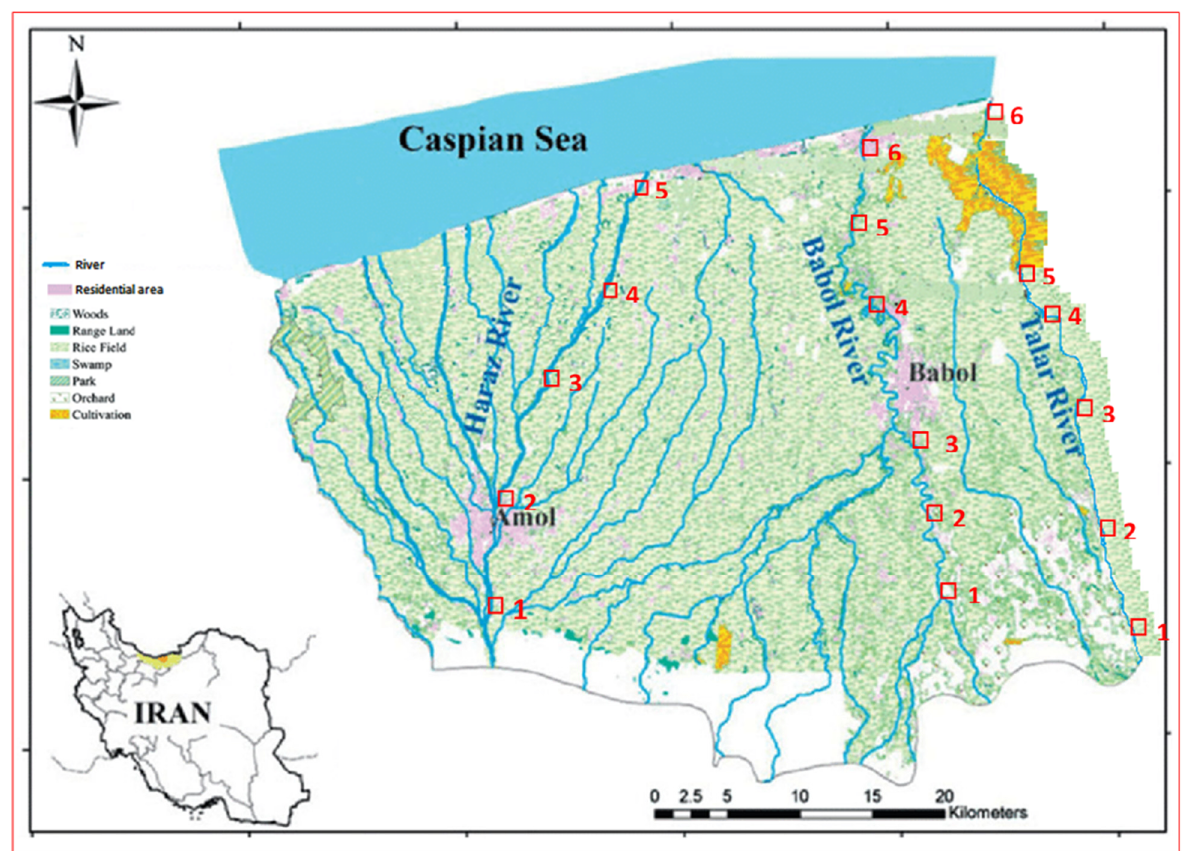
Figure 1. Sampling stations along the Talar, the Haraz and the Babolrood rivers.